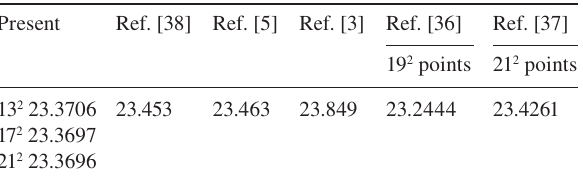
Table 1 Uni-axial buckling load of four-layer [0/90/90/0] SSSS laminated plate according to the higher-order theory 2